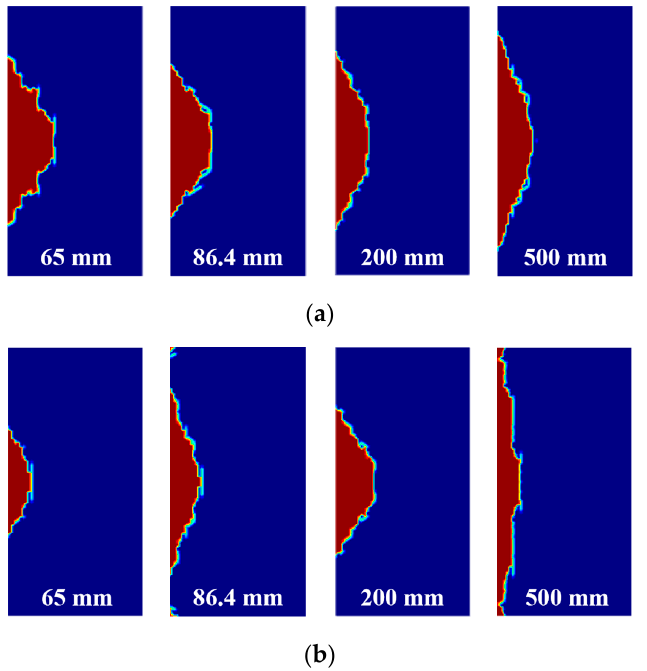
Figure 9. Plastic zone distribution of the rock sample and waveguide aperture under the irradiation time of 120 s. ( a ) Irradiation distance of 5 cm; ( b ) irradiation distance of 8 cm.